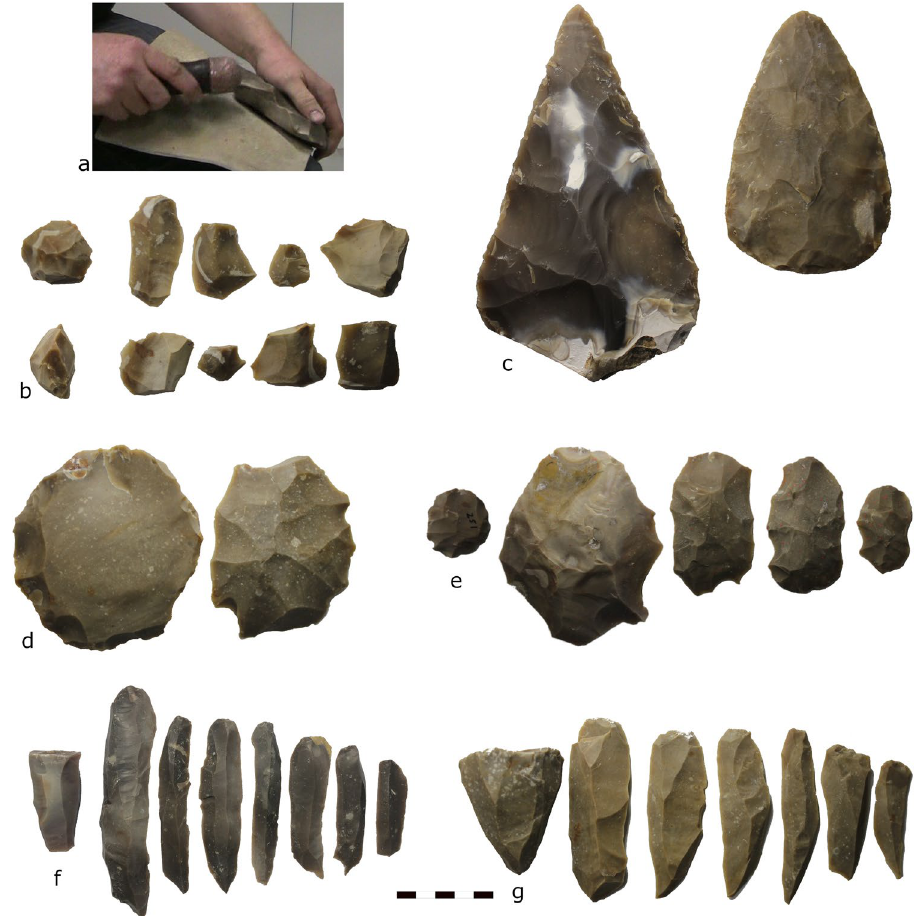
Figure 1. The experimental setup and examples of the lithics.( a ) Knapping footage. ( b ) Discoidal core and flakes. ( c ) Earlier (left) and later (right) handaxes. ( d ) Preferential Levallois core and flake. ( e ) Recurrent Levallois core and flakes. ( f ) and ( g ) Prismatic blade cores and